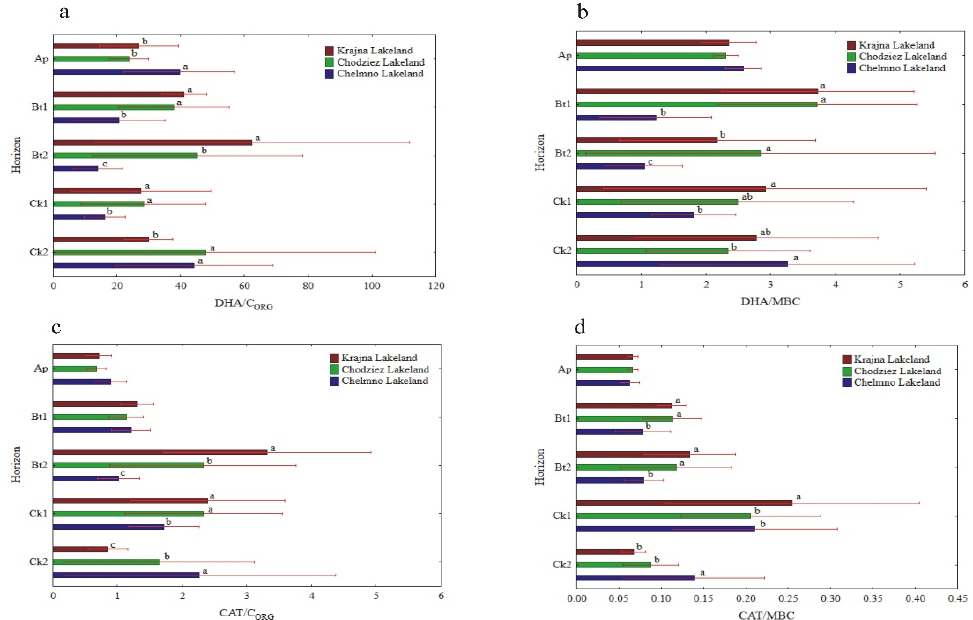
Figure 5. Activity of soil DHA and CAT at different soil horizons, expressed on an organic carbon (C ORG ) and microbial biomass carbon (MBC) basis; DHA/C ORG ( a ), DHA/MBC ( b ), CAT/C ORG ( c ) and CAT/MBC ( d ). Different lowercase letters indicate significant differences ( p < 0.05) between the study sites (within the same genetic horizon).